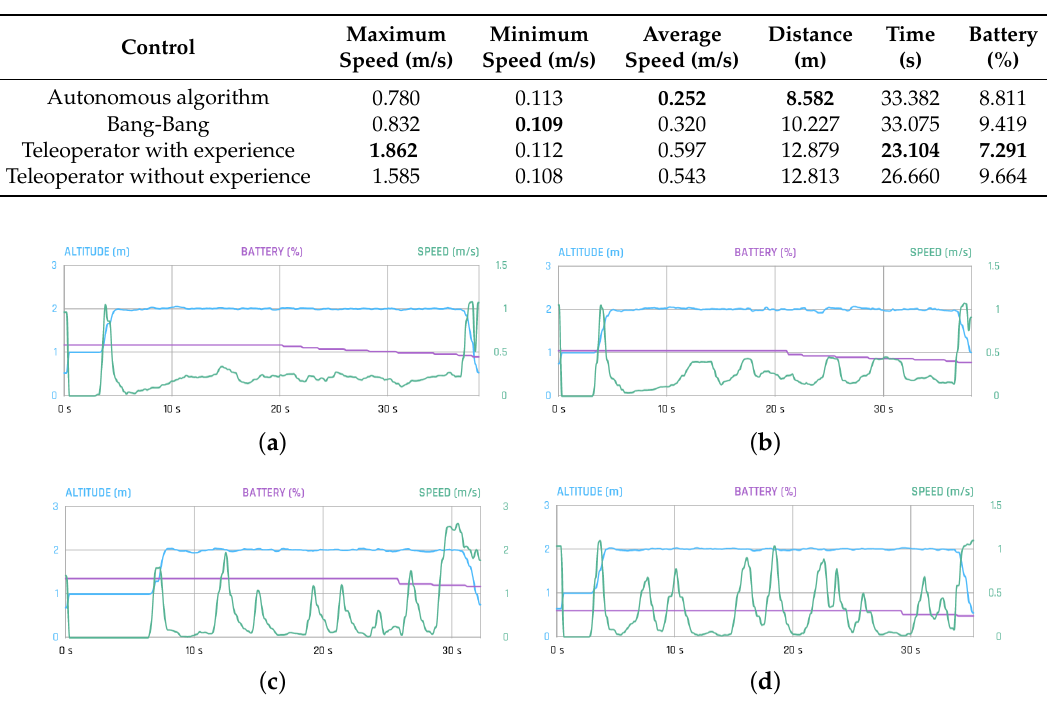
Figure 23. Results of two fixed obstacles for four different controllers. ( a ) Autonomous control; ( b ) bang-bang control ( c ) teleoperator with experience; ( d ) teleoperator without experience